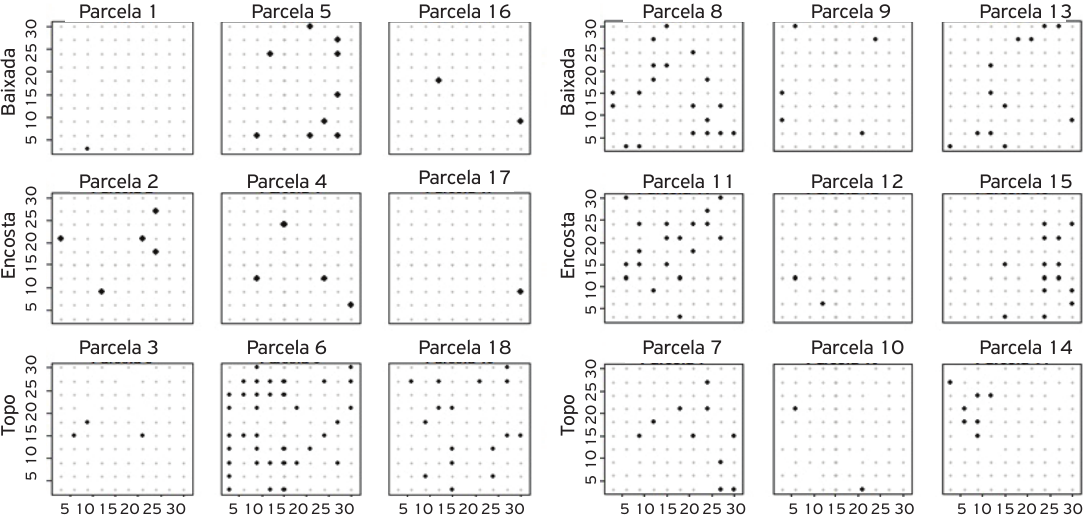
Figura 6. Distribuição do ataque de Heilipodus naevulus (Mannerheim, 1836) em áreas de plantio de clones de eucalipto, sob arranjo espacial de 3 x 3 m, no mês de março/2009, nos talhões 21 (7 – 12, 16 – 18) e 29 (1 – 6, 13 – 15), subdivididos em baixada, encosta e topo. Barão de Cocais